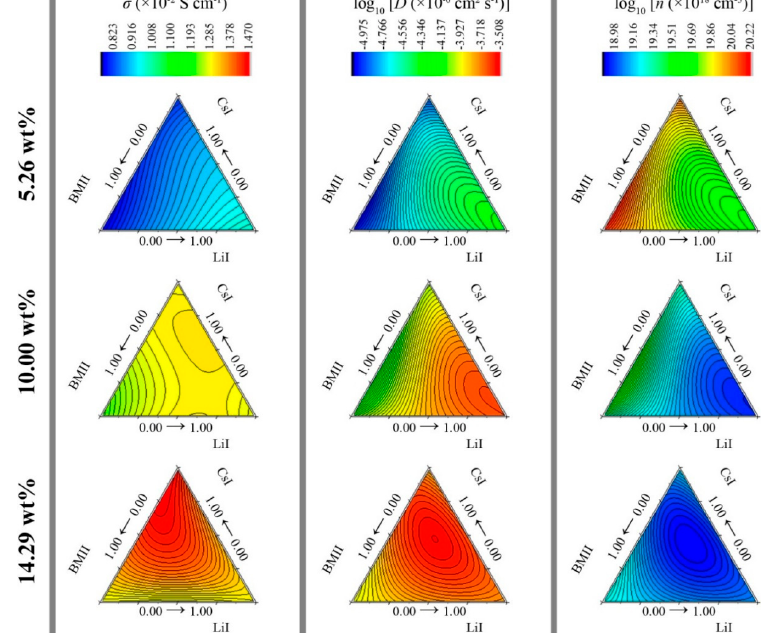
Figure 7. Plot of predicted RSM for σ (×10 − 2 S·cm − 1 ), log 10 [ D (×10 − 6 cm 2 ·s − 1 )], and log 10 [ n (×10 18 cm − 3 )] at various salt concentration levels.